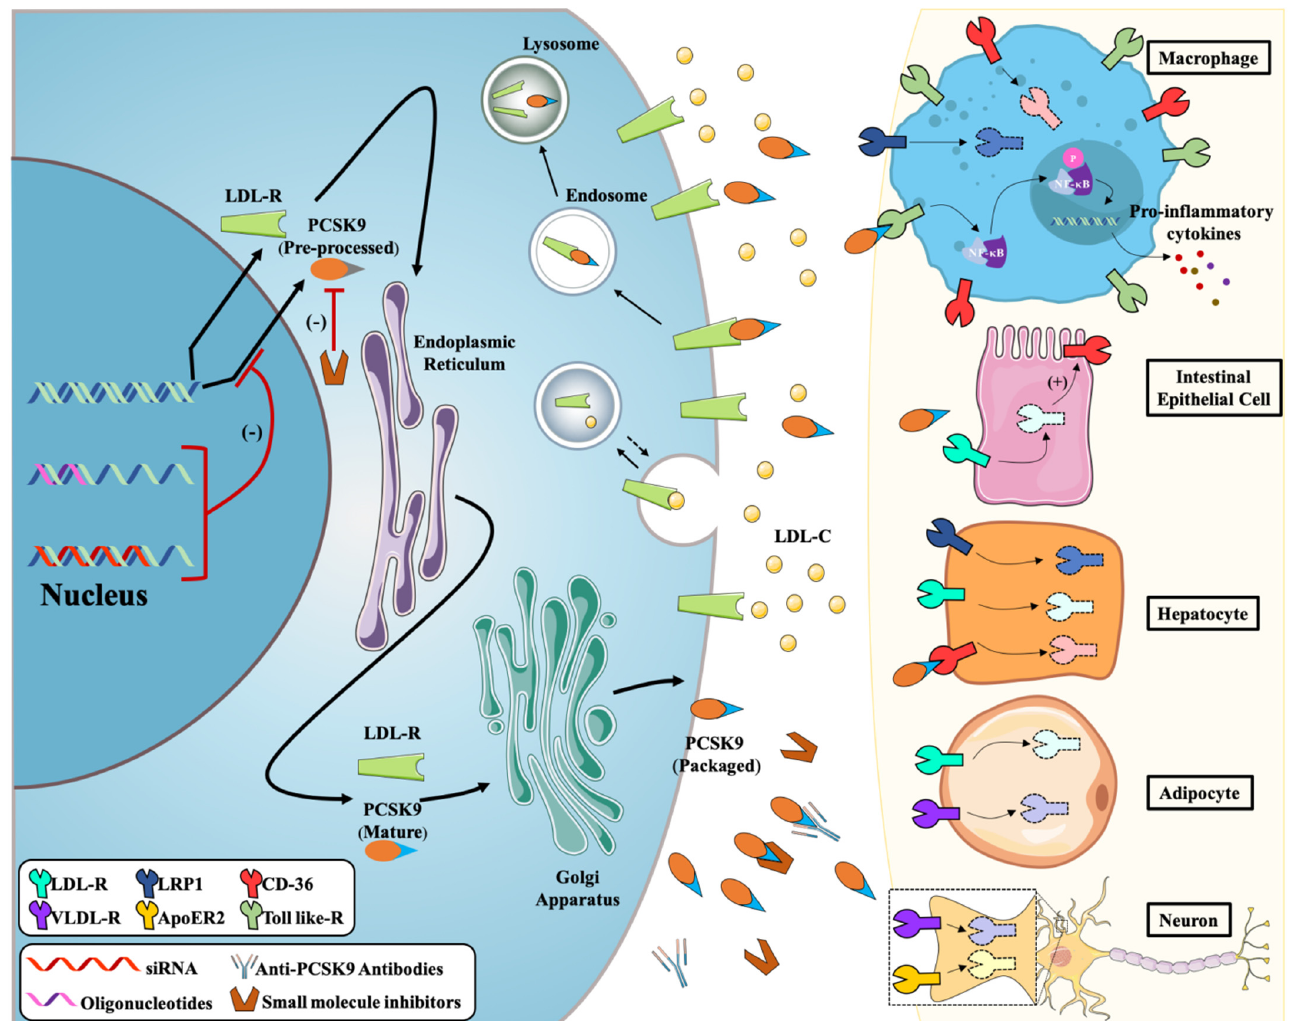
Figure 1. Molecular mechanisms of PCSK9 inhibitors with different strategies.